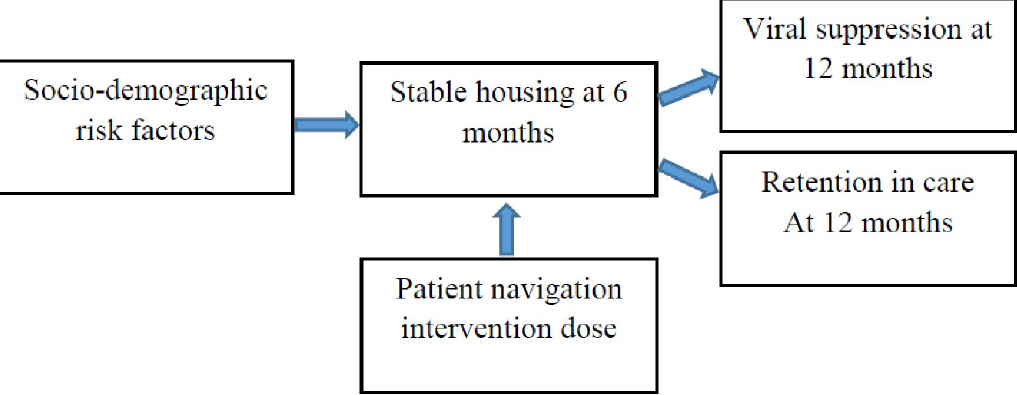
Fig 1. Hypothesized model for pathways from homelessness to housing stability to viral suppression and retention in care for people with HIV.